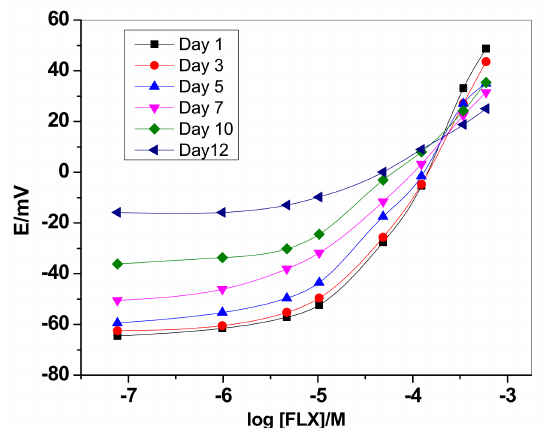
Figure 3. Day-to-day performance characteristics of ionophore III based sensor.